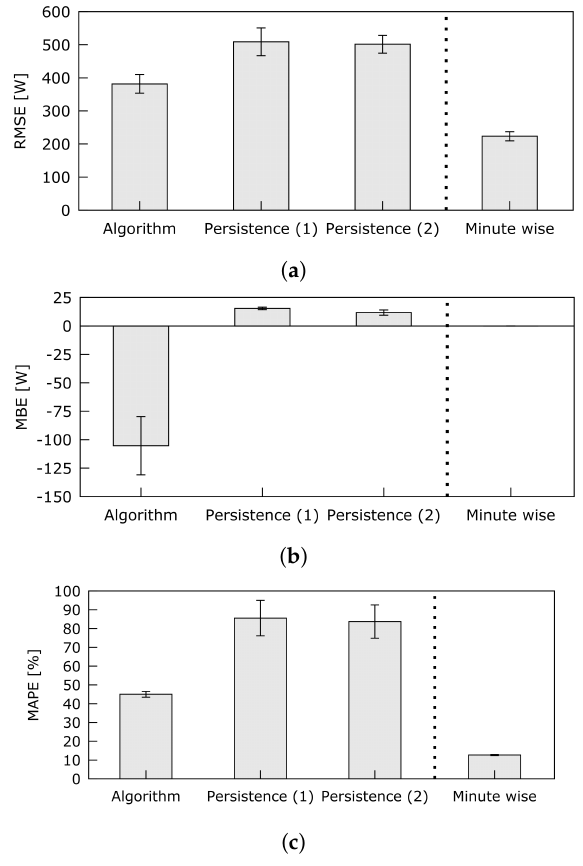
Figure 4. Error characteristics RMSE ( a ), MBE ( b ) and MAPE ( c ) of the forecast algorithm compared to three different